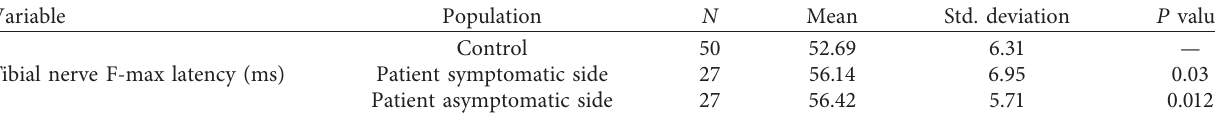
Table 4: Tibial nerve F-max (control vs symptomatic side and control vs asymptomatic